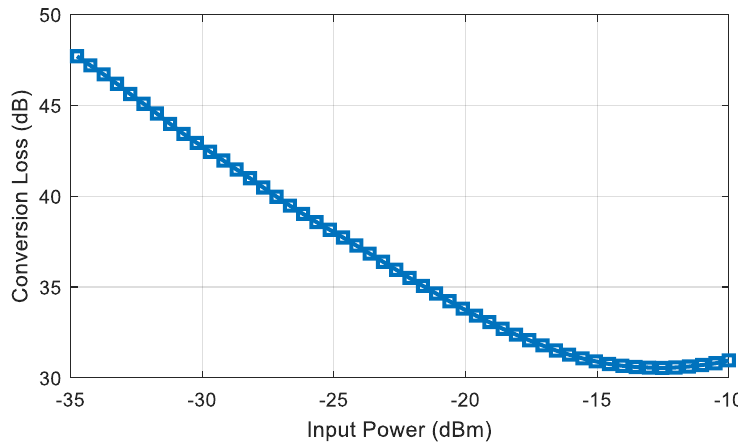
Figure 8. Measured conversion loss as a function of input power when the frequency doubler is modulated with a 32 KHz 0.45 V square wave.